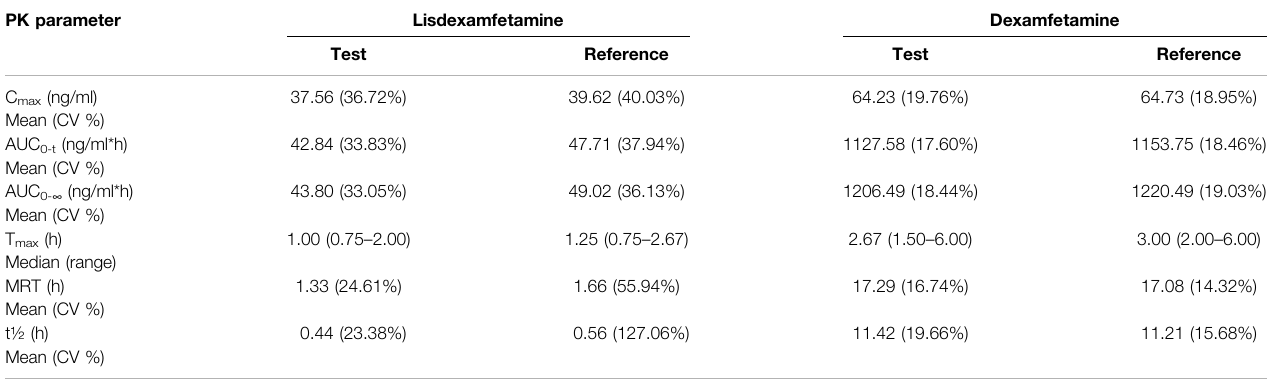
TABLE 2 | Mean lisdexamfetamine and dexamfetamine pharmacokinetic parameters after a single oral dose of 70 mg lisdexamfetamine dimesylate consisting of either a volume of 7 ml Lisdexamfetamine dimesylate 10 mg/ml oral solution (TEST) or one hard capsule of Elvanse ® (REFERENCE), administered to fasting healthy volunteers (N = 29).